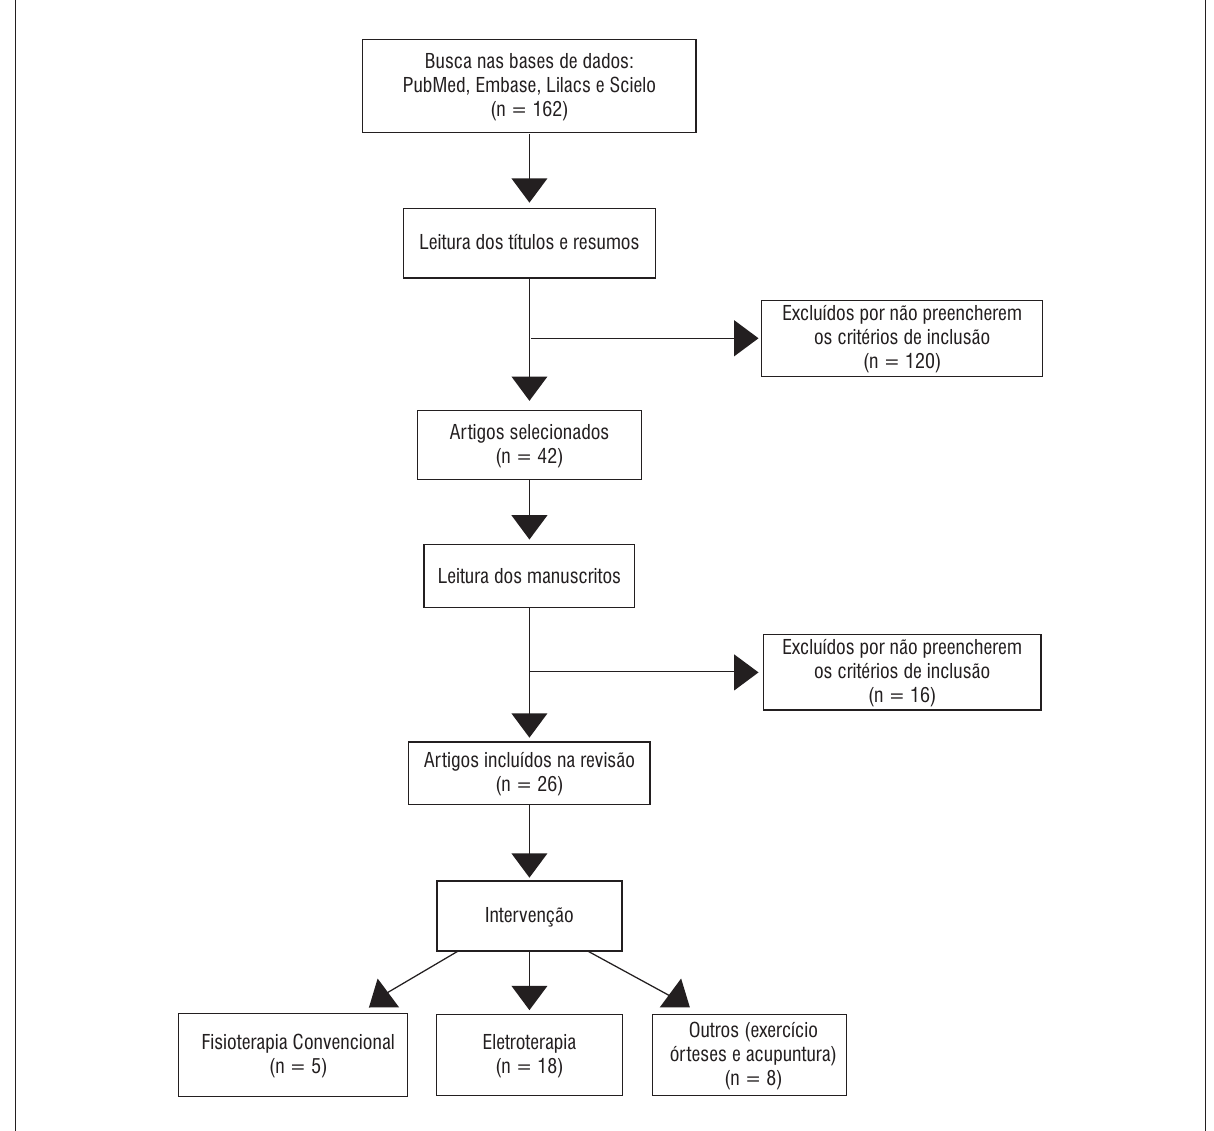
Figura 1 – Fluxograma do processo de inclusão dos artigos na revisão sistemática Fonte: Dados da